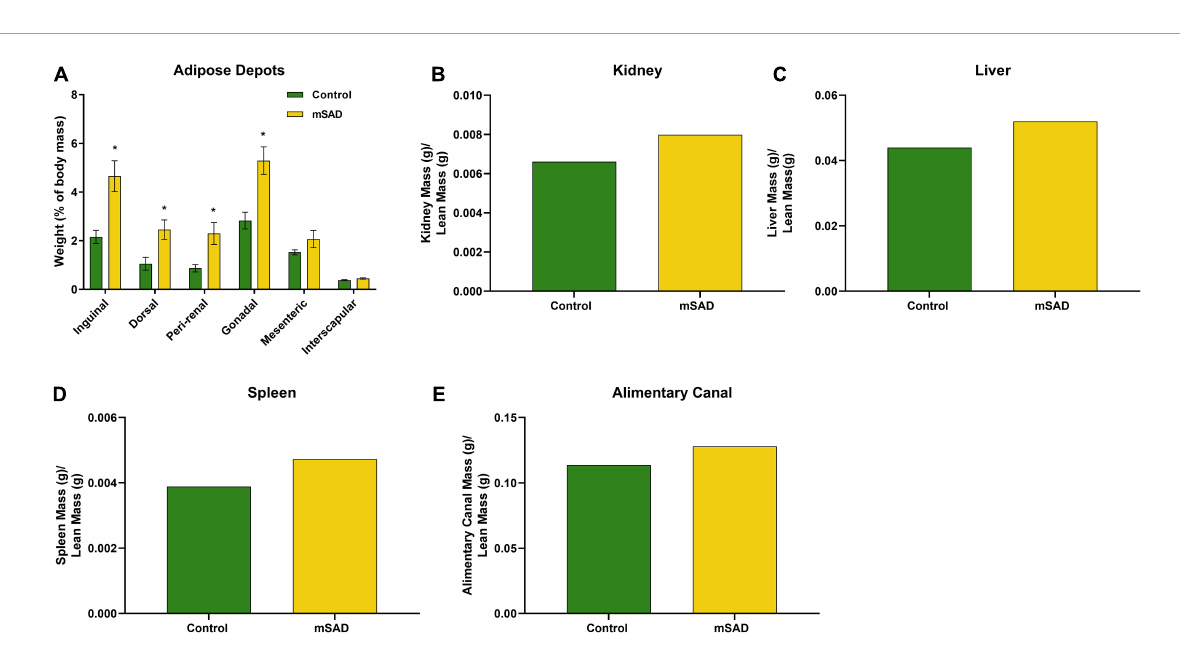
FIGURE4 Effects of diet on an adipose depot and organ weights. Weights of the inguinal, dorsal, peri-renal, gonadal, mesenteric, and interscapular adipose depots were compared between CON- and mSAD-fed mice after 15 weeks of feeding (A) . Kidney (B) , liver (C) , spleen (D) , and alimentary canal (E) weights were also evaluated in both groups. Adipose depot values are represented as % of total body mass. Organ weight values are represented as absolute mass normalized by regression-predicted lean mass (g/g). When possible, data were compared using Student’s t-tests. * p <